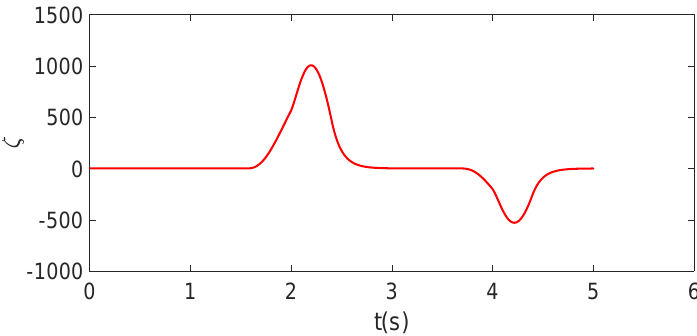
Figure 21. State of the anti-windup